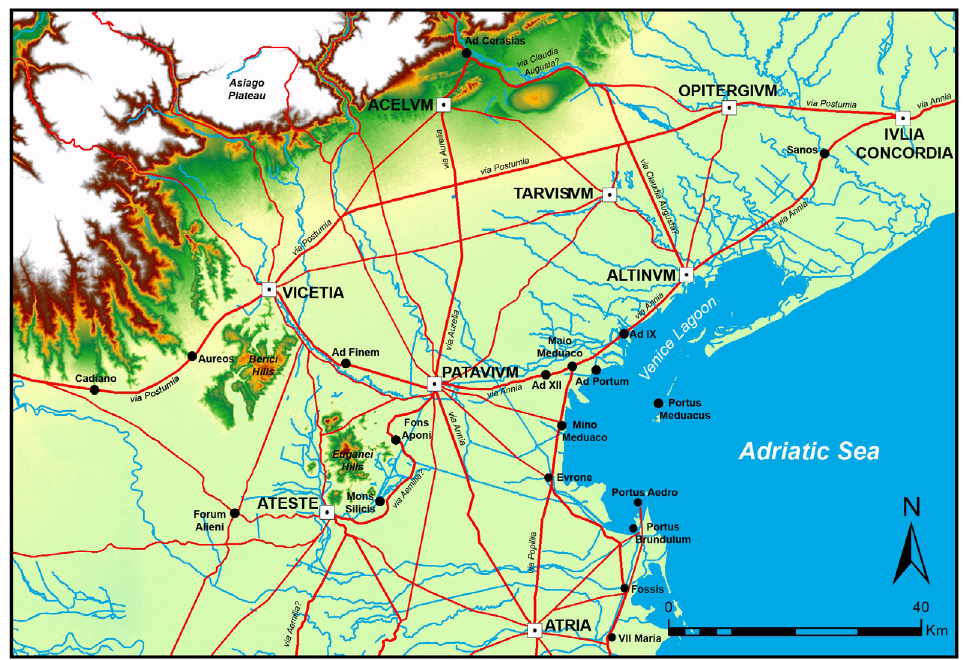
Fig. 4 The main Roman road network in ancient Venetia . Legend: red lines: Roman roads; blue lines: present-day river network; white black dotted squares: urban centers; black dots: minor